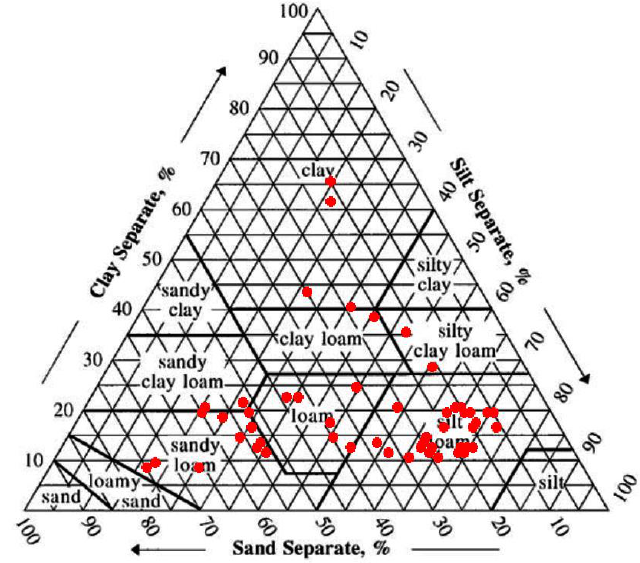
Figure 4. Textural composition of soils investigated.